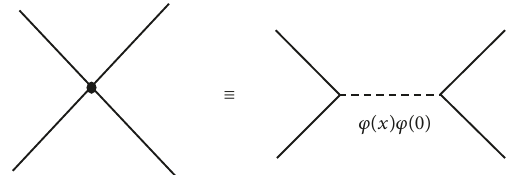
Figure 8: The four-point effective vertex contains two interaction vertices with the soft sector, along with a propagator of the same soft sector. The dashed horizontal line is the soft sector propagator, and the solid lines are external hard